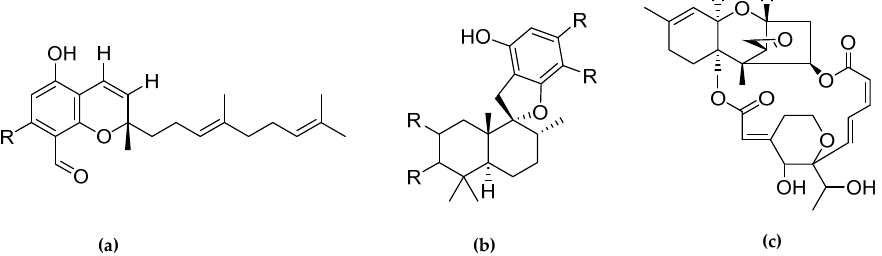
Figure 1. Chemical backbones of the tested compounds: ( a ) stachybotrychromenes, ( b ) phenylspirodrimanes and ( c ) macrocyclic trichothecenes.